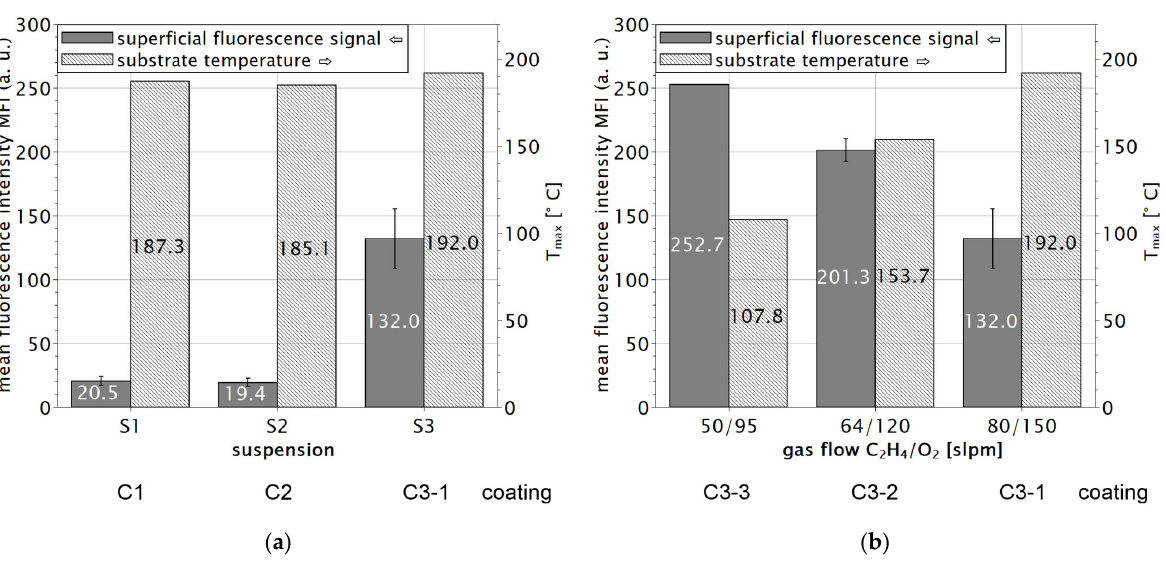
Figure 6. Superficial fluorescence intensity (average of minimum 2 images, measured at 100x magnification, 20 ms exposure) depending on suspension formulation: ( a ) and gas flow: ( b ) in comparison with maximum substrate temperatures measured during coating deposition.